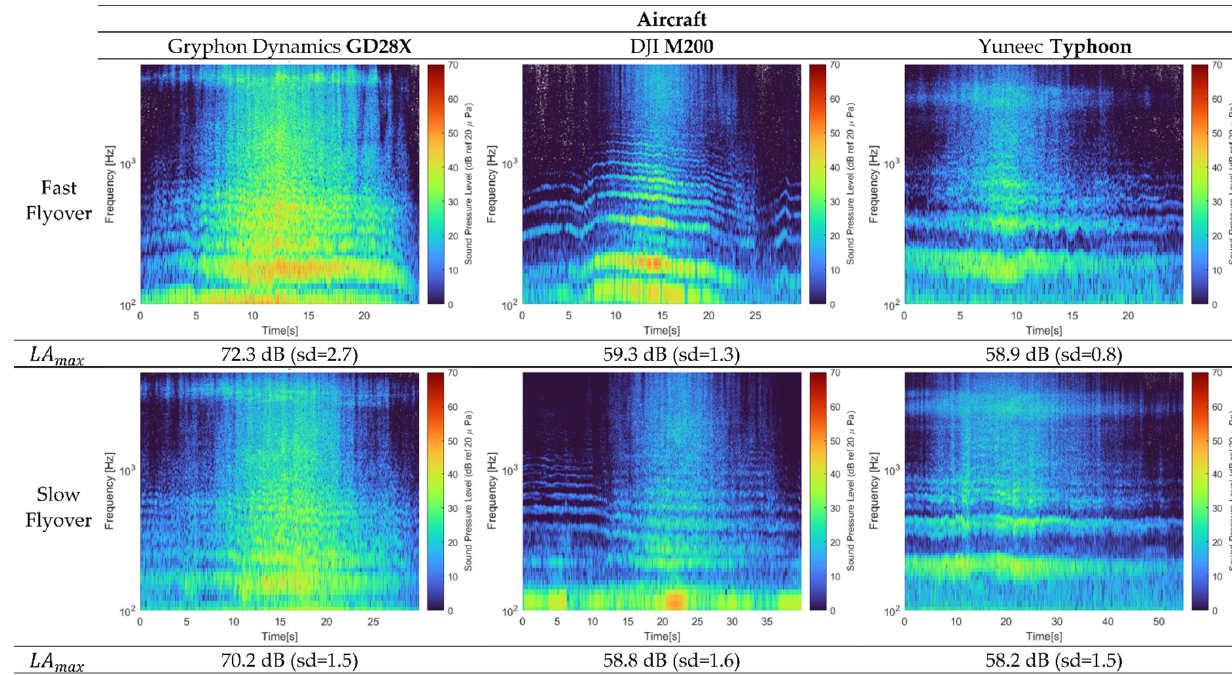
Figure 3. Spectrograms and 𝐿𝐴 (cid:3040)(cid:3028)(cid:3051) values for three drone models: GD28X ( left ), M200 ( middle ), and Typhoon ( right ) during fast ( top ) and slow ( bottom ) flyover operations at ~47.5 m altitude above the CLG. Data adapted with permission from Ref. [18].